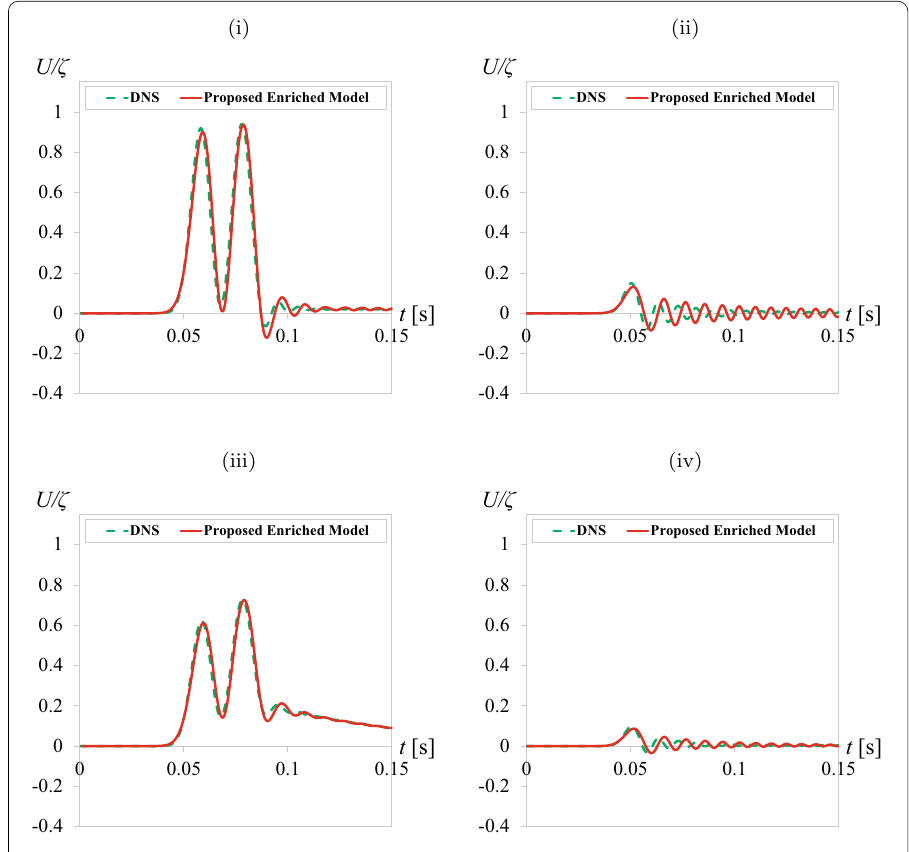
Fig. 9 Metamaterial 1—Homogenized displacement profiles at x = 20 D , with respect to relaxation time [B] ( κ = 0 . 256 s ) for loading frequency F at i 50 Hz, ii 1000 Hz, and with respect to [C] ( κ = 0 . 0255 s ) for F at iii 50 Hz, iv 1000